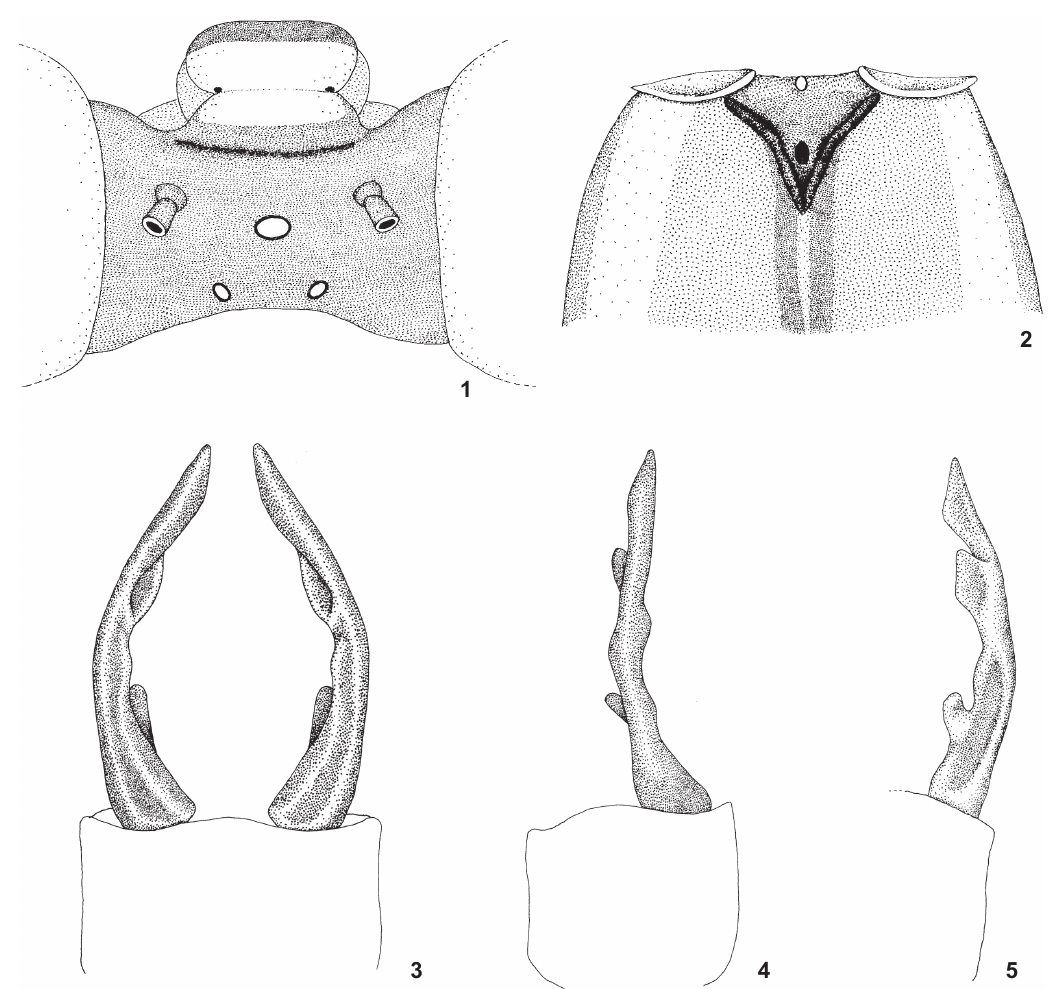
Figures 1-5. Perilestes eustaquioi sp. nov. : (1) head, dorsal view; (2) anterior part of pterothorax, dorsal view; (3-5) cerci: (3) dorsal, (4) lateral and (5) mediodorsal views.